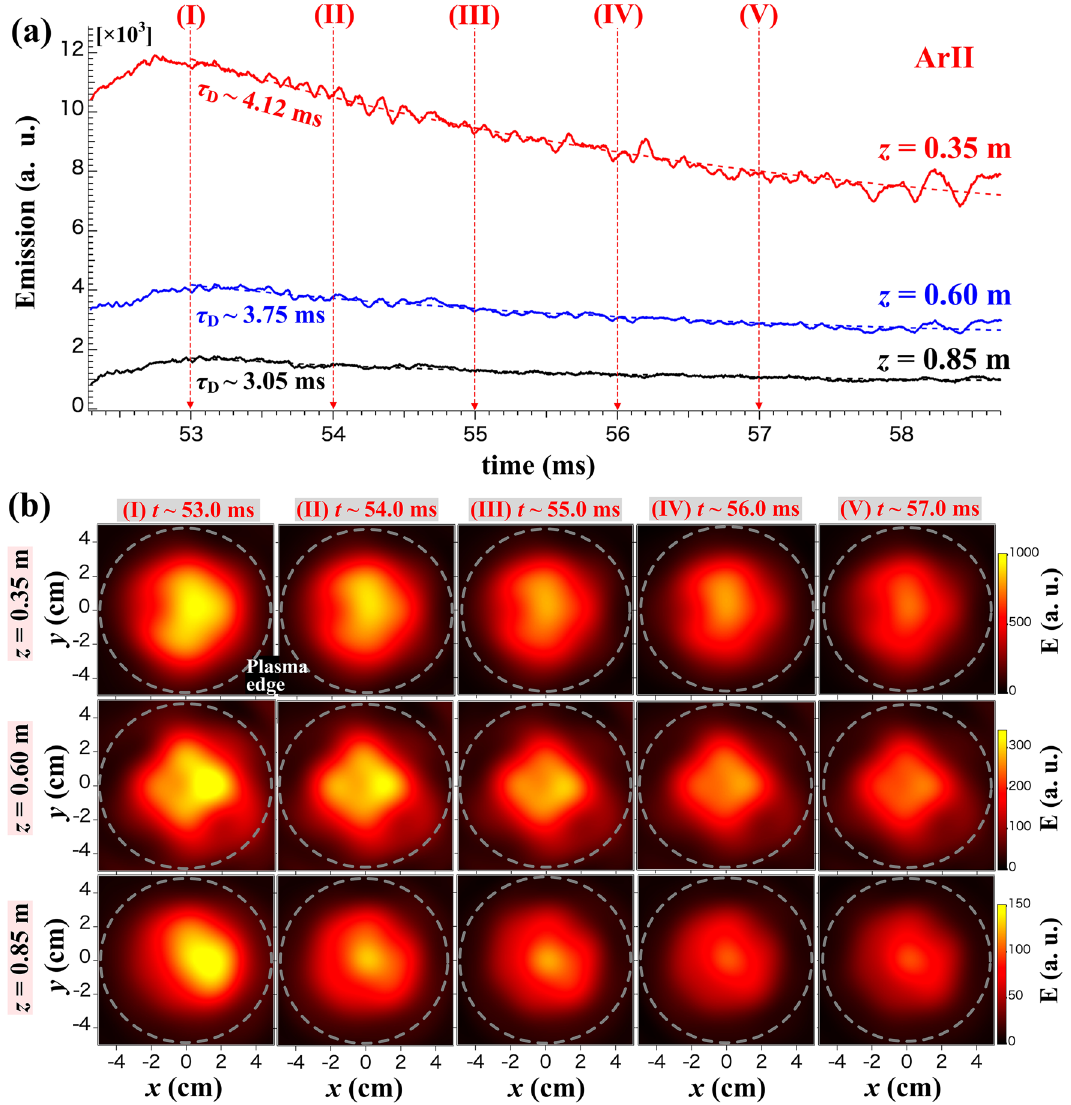
Figure 4. ( a ) Temporal evolution of the total emission and ( b ) two-dimensional images of emission at the three axial positions during the relaxation phase, z = 0.35, 0.60, and 0.85 m. The images are obtained using the FBF fitted to MLEM profile. The dashed circles indicate the plasma